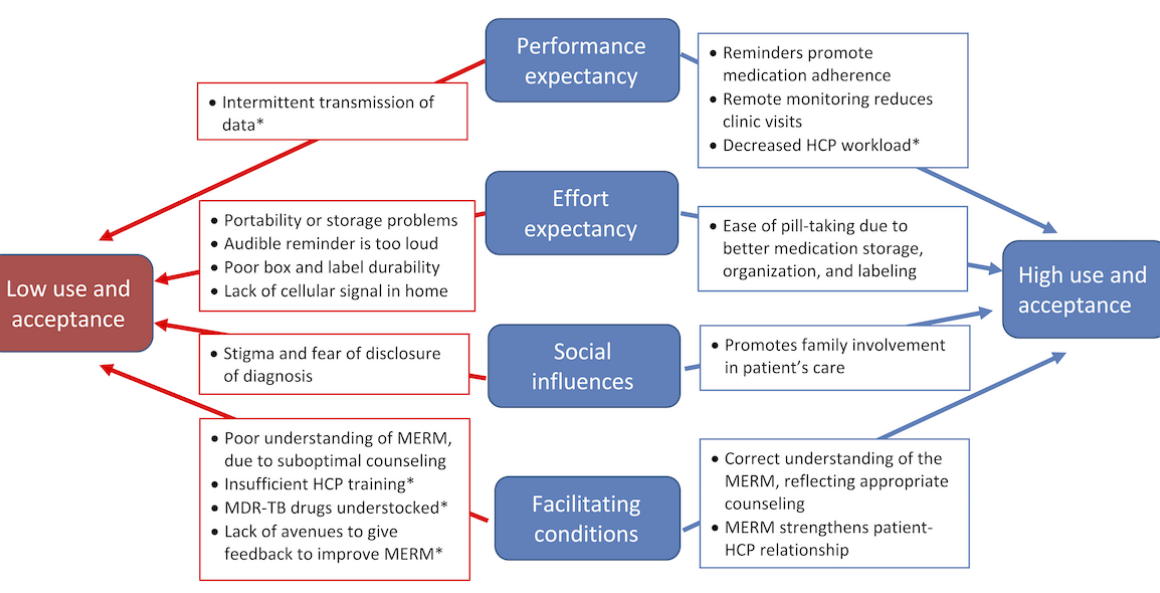
Figure 2. Key findings regarding determinants of high and low acceptance and use of the Medication Event Reminder Monitor by patients with MDR-TB and health care providers based on the Unified Theory of Acceptance and Use of Technology (UTAUT) framework. *Findings are from health care provider interviews; all other findings are from patient interviews. HCP: health care provider; MERM: Medication Event Reminder Monitor; MDR-TB: multidrug-resistant